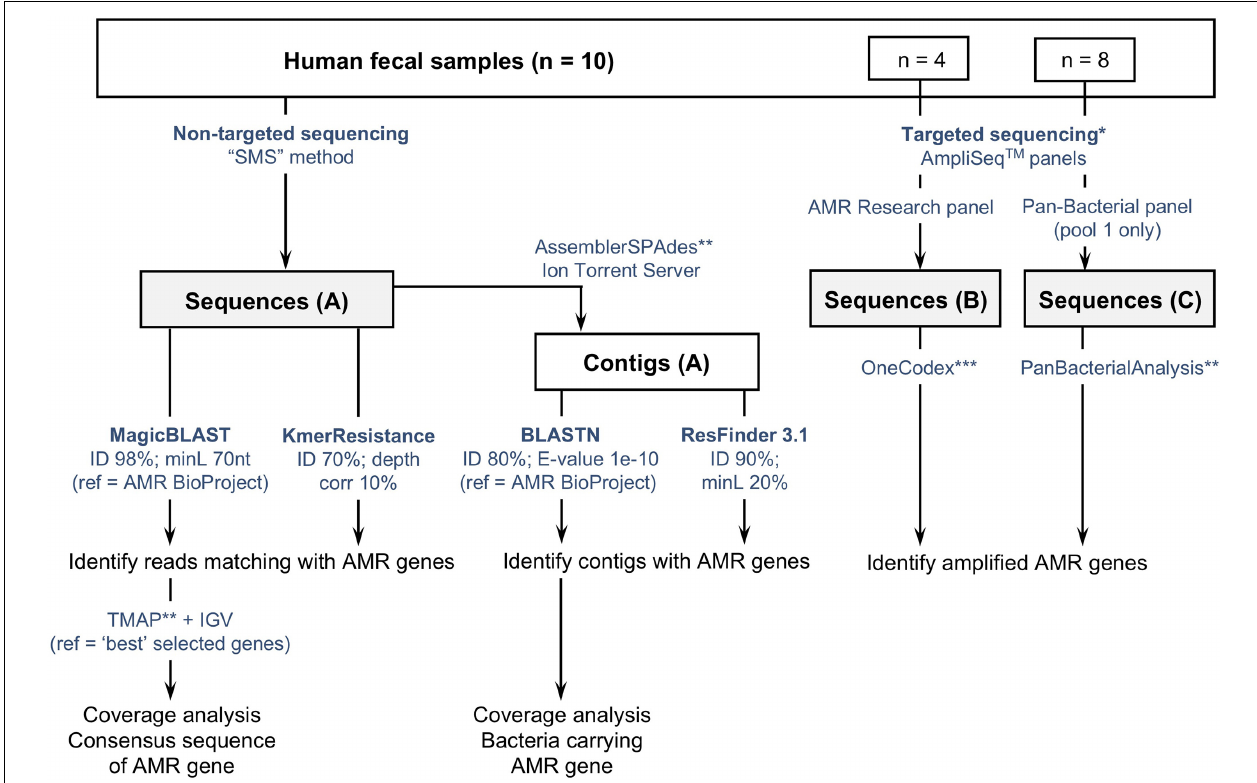
FIGURE 1 | Flowchart describing three culture-independent methods to identify the presence of antimicrobial resistance genes (ARGs) in fecal samples ( n = 10). (A) Non-targeted sequencing of sheared DNA or “Shotgun Metagenomic Sequencing” (SMS) method; (B,C) targeted sequencing using two commercially available AmpliSeqTM panels targeting ARGs. Sequences obtained with the SMS method were analyzed using two web-based tools (ResFinder and KmerResistance, https://cge.cbs.dtu.dk/services/), and a method based on the comparison of reads and contigs against the NCBI-curated “Bacterial Antimicrobial Resistance Reference Gene Database” (https://www.ncbi.nlm.nih.gov/bioproject/PRJNA313047). *Targeted sequencing was tested on a subset of samples: 4 with the AMR Research panel, 8 with the Pan-Bacterial Research panel. **refers to Ion Torrent Suite plugins available from the Thermo Fisher Scientific Plugin store. ***Refers to the “One Codex” online platform (available at: https://app.onecodex.com/) used with the AMR Research panel. “ID”: percentage identity threshold; “minL”: minimum length: minimum percentage of coverage compared to reference length or minimum number of nucleotides (nt); “ref”: reference sequences used for comparison with